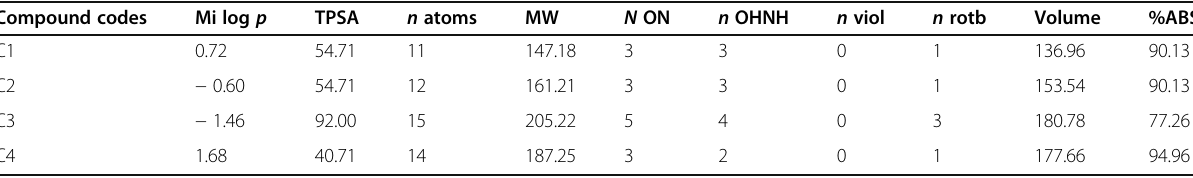
Table 2 Bioactivity scores Compound